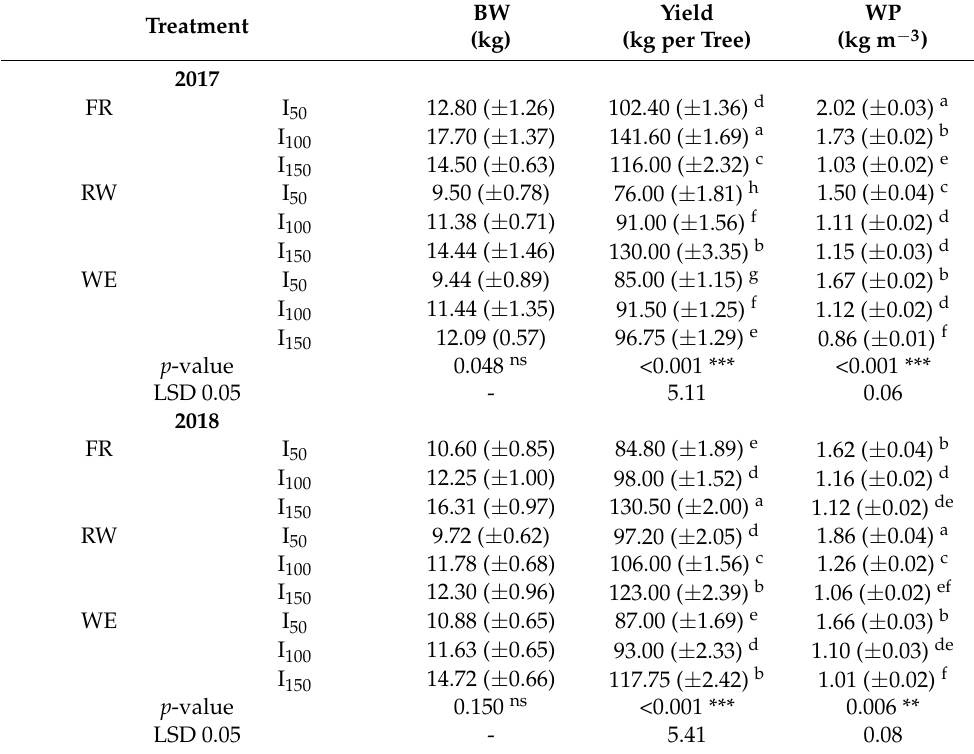
Table 4. Comparison of bunch weight (BW), yield, and water productivity (WP) of date palms across the experimental treatments from 2017 to